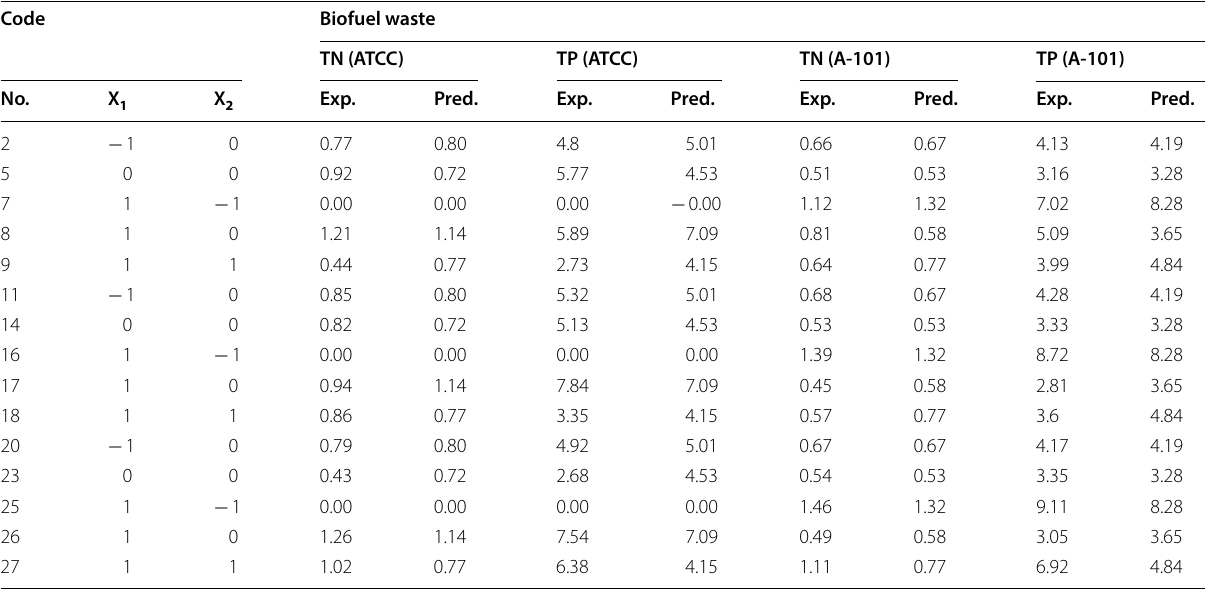
Table 3 Experimental design with experimental and predicted values of protein concentration in wet biomass of Yarrowia lipolytica strains obtained in cultivation on biofuel waste (SK medium) Code Biofuel waste